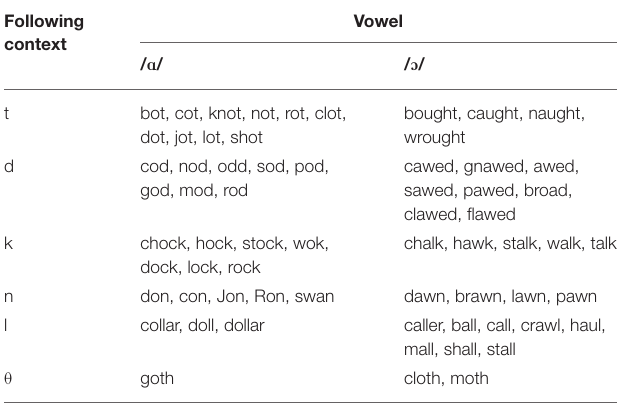
TABLE 1 | Contrastive contexts in US varieties without merger of / A / and / O /. Following context